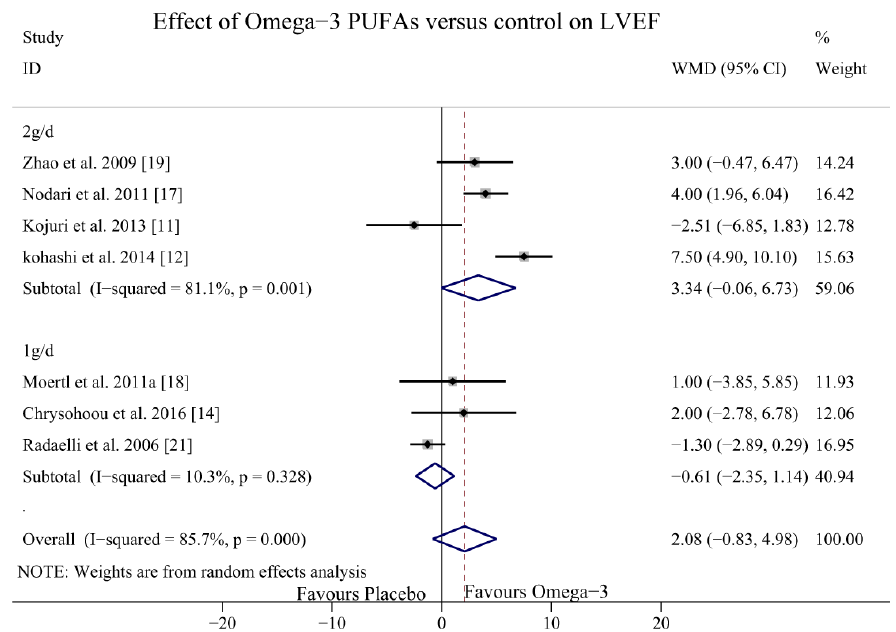
Figure 7. Forest plot depicting the dose-effect of omega-3 PUFAs on LVEF (WMD, weighted mean difference). Abbreviations: LVEF, left ventricular ejection fraction; PUFAs, polyunsaturated fatty acids.